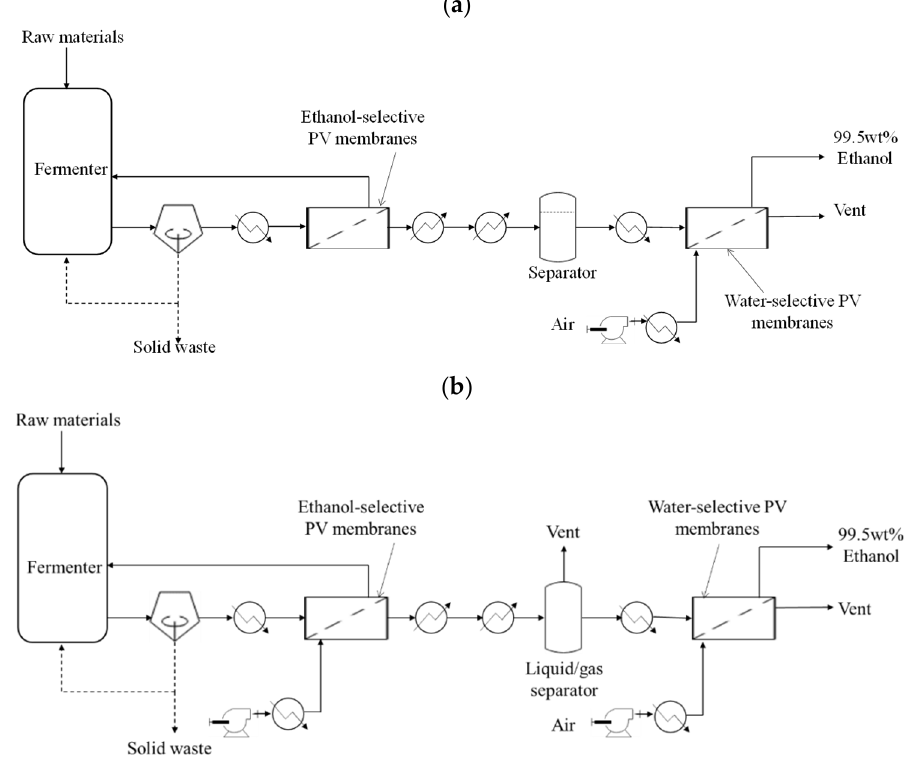
Figure 7. Downstream process consisting of two types of membranes: ( a ), a diagram of ethanol- selective membrane with vacuum followed by water-selective membrane with sweep; ( b ), diagram of ethanol- and water-selective membranes with sweep.